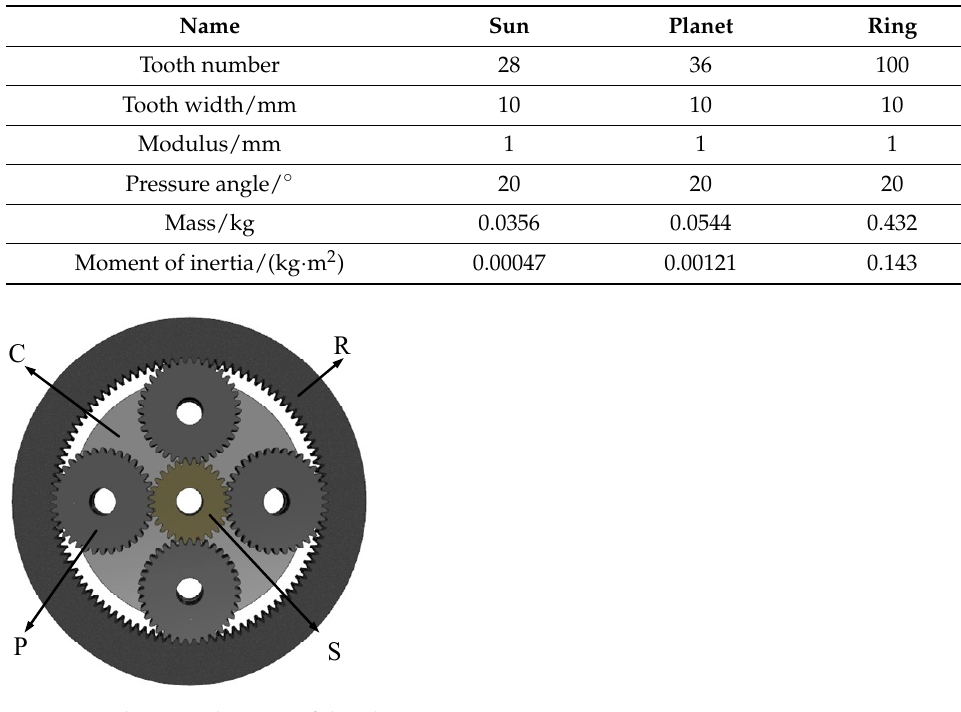
Figure 1. Schematic diagram of the planetary gear train structure. Table 1. Planetary gear transmission system parameters.